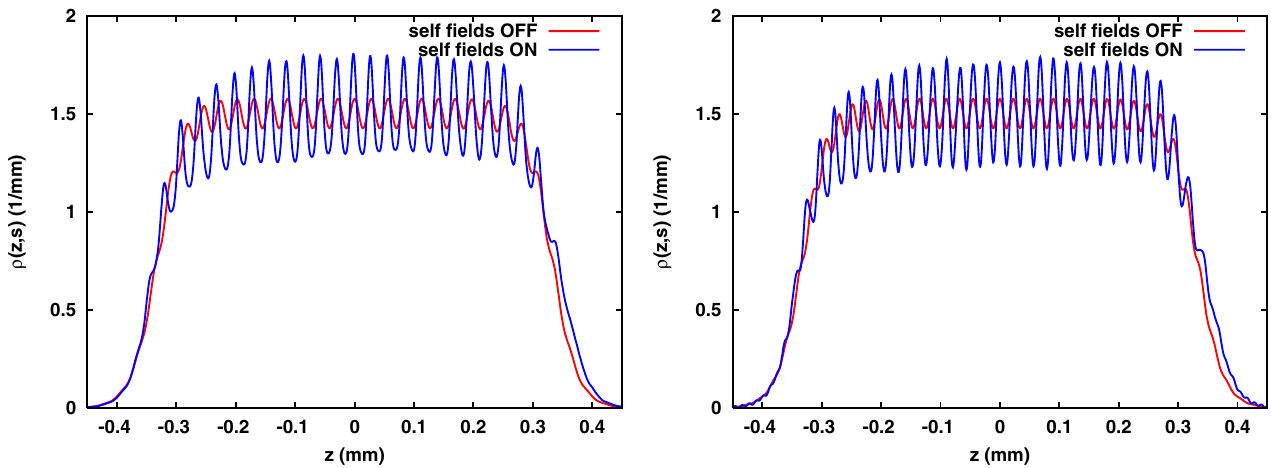
¼ 100 (cid:4) m (left) and (cid:2) 0